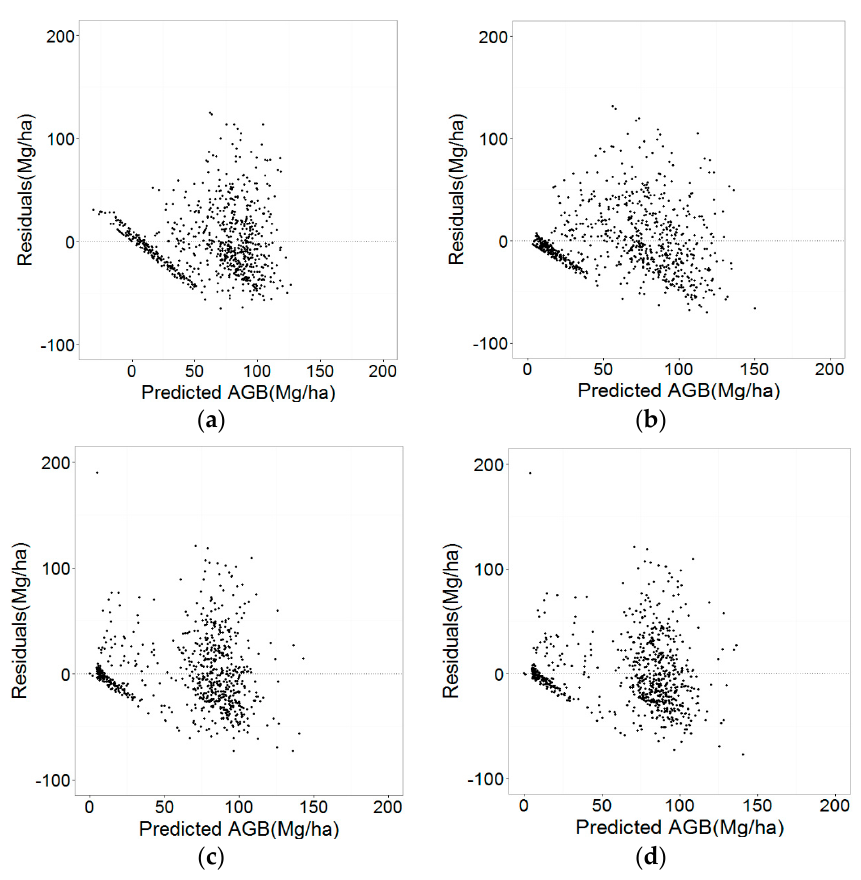
Figure 5. Distributions of residuals for predictions of sample plot AGB from: ( a ) the multivariate linear regression (MLR); ( b ) the logistic regression (LR); ( c ) g-kNN with k = 10 nearest neighbors; and ( d ) CW-kNN with k = 10 nearest neighbors.